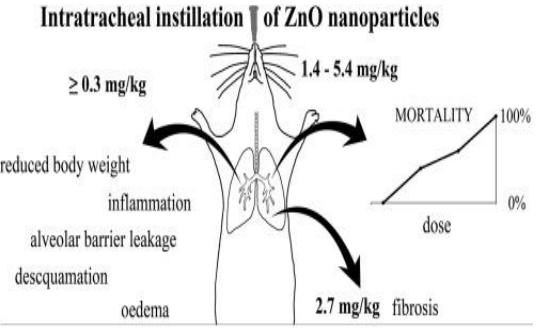
Figure 37. Pulmonary toxicity and mortality in mice administered with nZnO of different sizes, shapes and doses. Intratracheal instillation of ZnO NPs with doses ≥0.3 mg/kg leads to acute pulmonary inflammation (left panel). Pharyngeal aspiration of high ZnO rod doses (≥1.4 mg/kg) leads to a dose dependent mortality in the mice (right panel). Reproduced from [180] under the Creative Commons Attribution license.